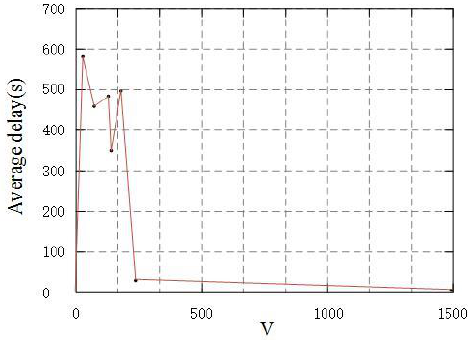
Figure 3. The weight-dependent trend of average delay.